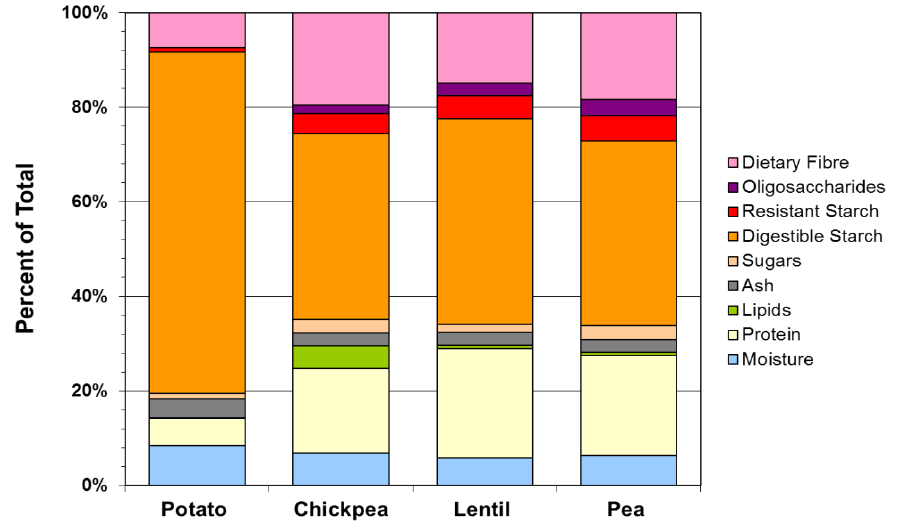
Figure 1. Representation of the composition of pulse ingredients and instant mashed potato product.